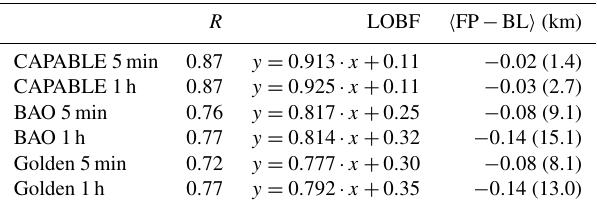
Table 2. Summary of aggregate statistics for the Python-collected (FP)/STRAT-processed and the BLView-collected (BLV)/STRAT- processed MLH estimates ( y and x , respectively). Data were resam- pled to 5min resolution followed by application of filtering criteria to both data sets (lines labeled 1h present statistics after data were filtered and subsequently resampled by a 1h block average). Values in parentheses indicate percent of the difference value with respect to the BLView-derived